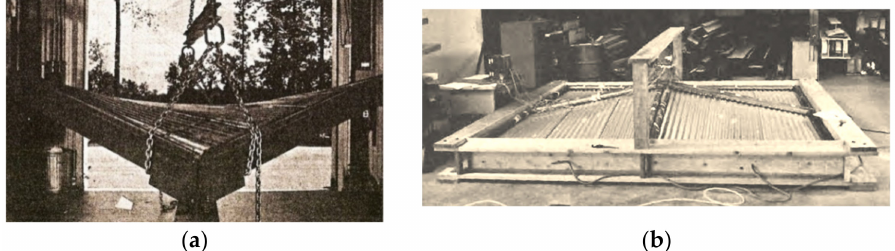
Figure 3. Two symmetric experimental hyperbolic paraboloid shells: ( a ) a complete shell; ( b ) an umbrella structure of four